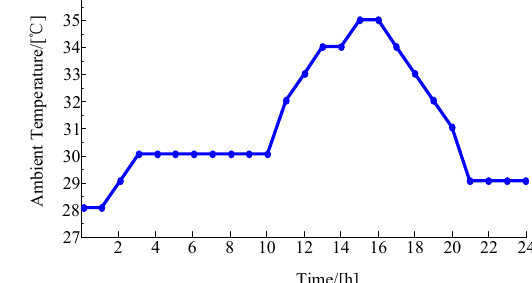
Figure 4. Wind power scenarios.